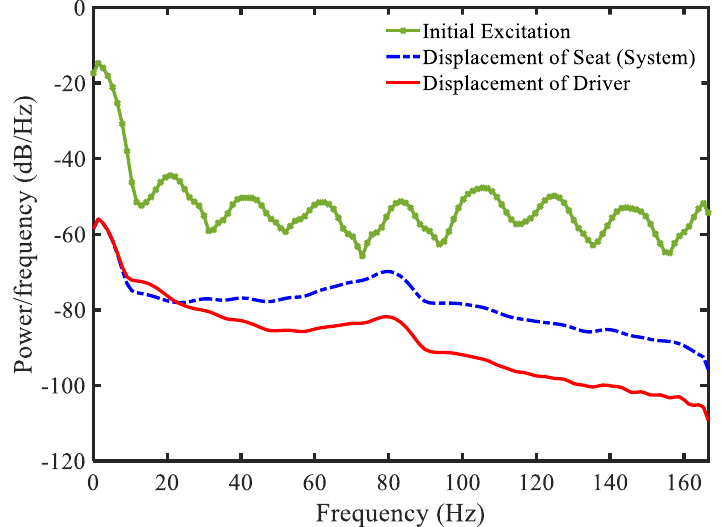
Figure 17. Power spectral density of the proposed control system under random step wave road